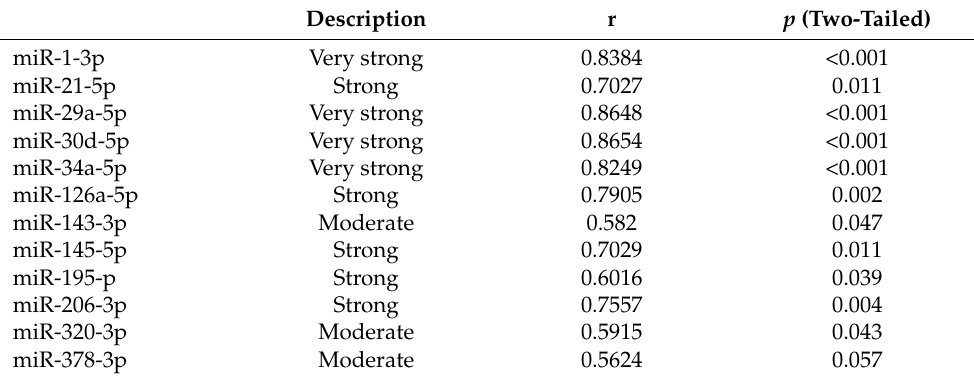
Figure 5. Expression of miRNAs in diabetic HFpEF hearts. The levels of miRNAs were examined using stem-loop RT-qPCR. ( A ) miR-1-3p. ( B ) miR-21-5p. ( C ) miR-29a-5p. ( D ) miR-30d-5p. ( E ) miR- 34a-5p. ( F ) miR-126-5p. ( G ) miR-143-3p. ( H ) miR-145-5p. ( I ) miR-195-5p. ( J ) miR-206-3p. ( K ) miR- 320-3p. ( L ) miR-378-3p. Data are expressed as mean ± SEM ( n = 6). p -values were determined by Student’s t -test. * p < 0.05 DM vs. C. Table 1. Pearson correlation between cardiac miRNAs and cardiac output.